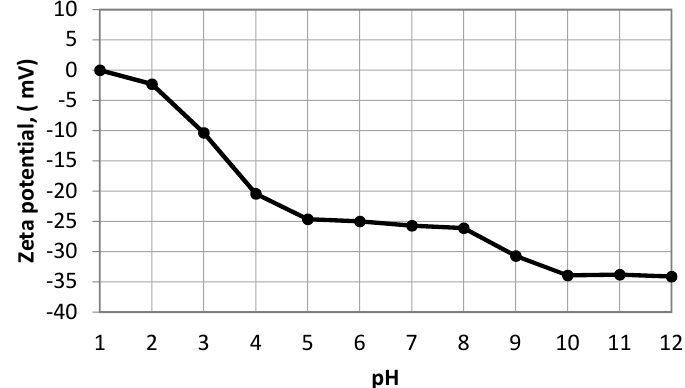
Figure 9. Zeta potential of fabricated membrane as a function of pH.